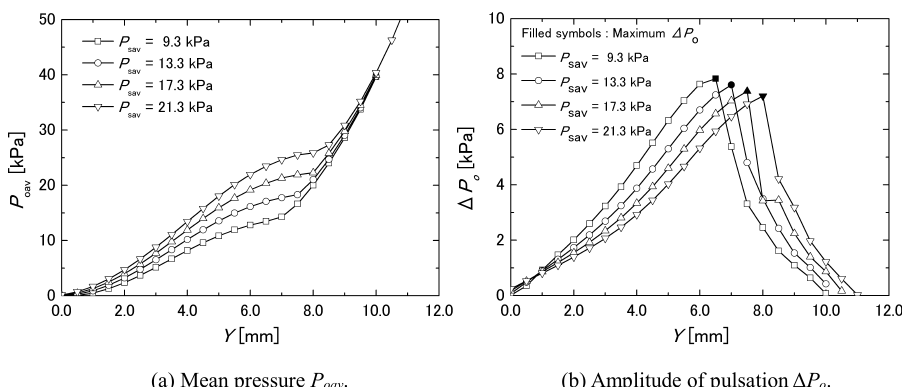
Fig. 6 Numerical reproduction of indentation experiment with four mean supply pressure P sav .